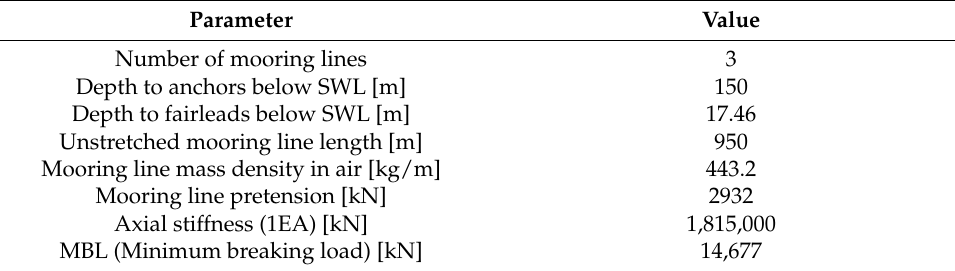
Table 3. Specifications of 10 MW S-FOWT mooring